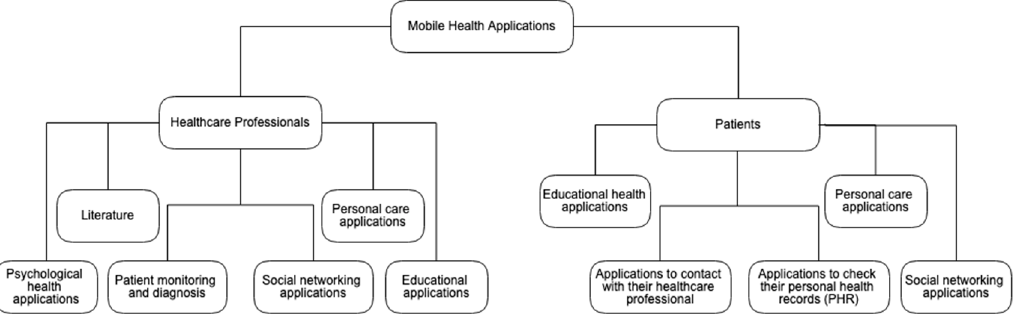
Figure 1. Classification of mobile health applications studied.